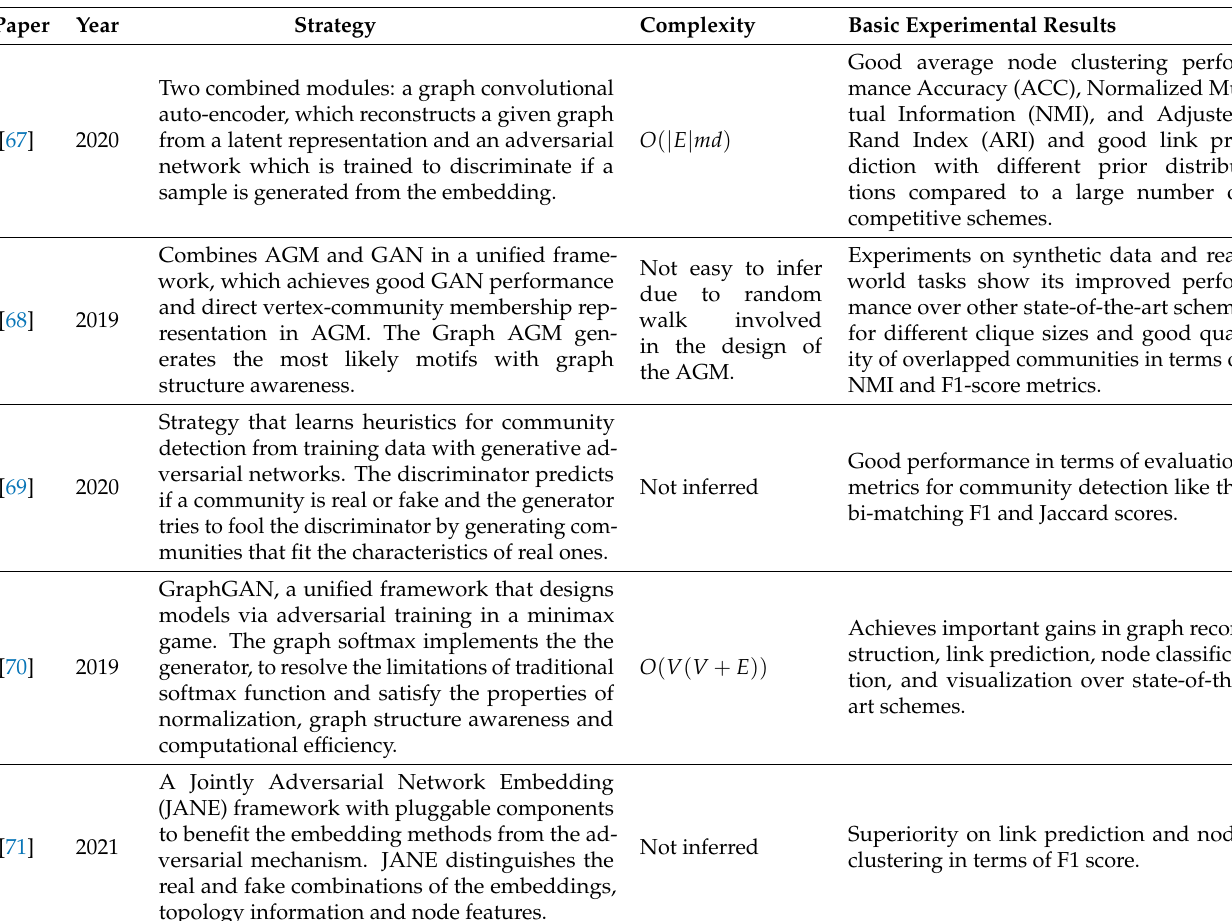
Table 3. GAN-based community detection